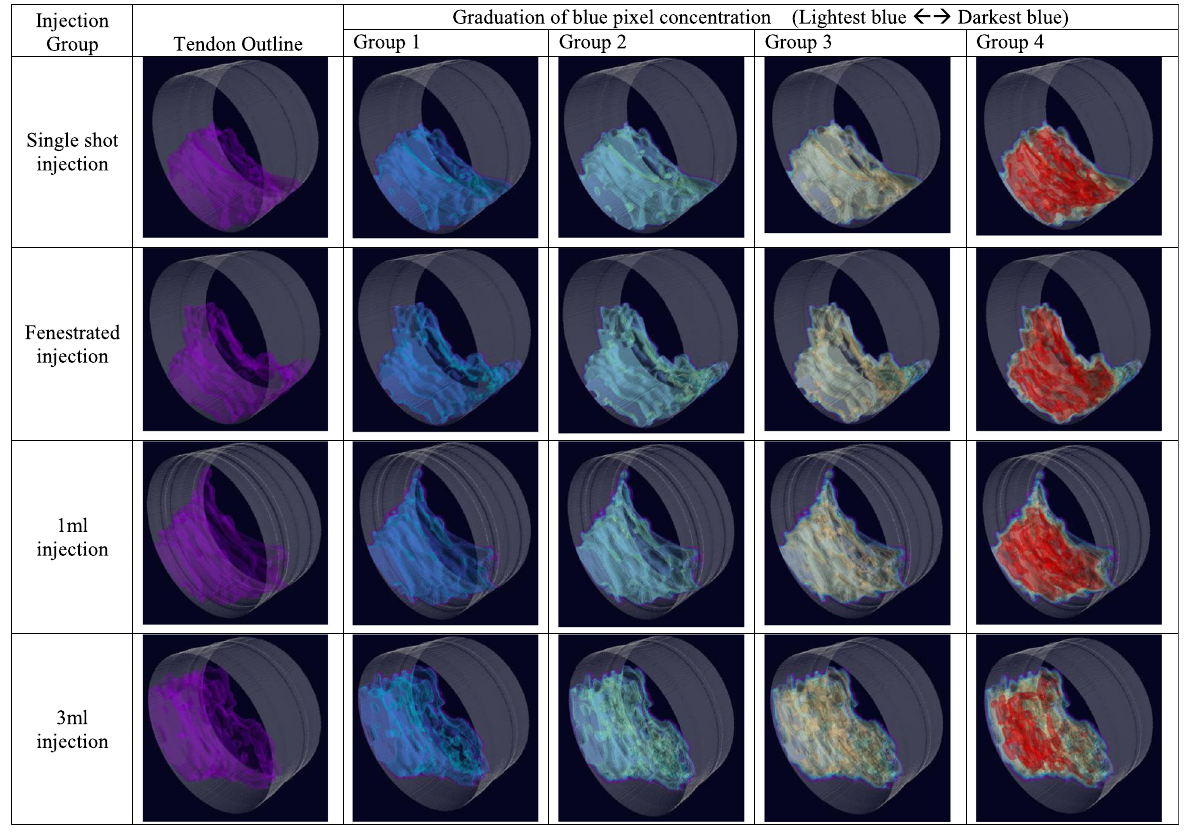
Fig. 5 Examples of 3-Dimensional reformats of tendon segments for the four injection techniques. From left – tendon boarder, then working through four colour intensity contours. Note no pattern of pooling or longitudinal spread. (Video examples of the four groups of injections are available in the Additional file